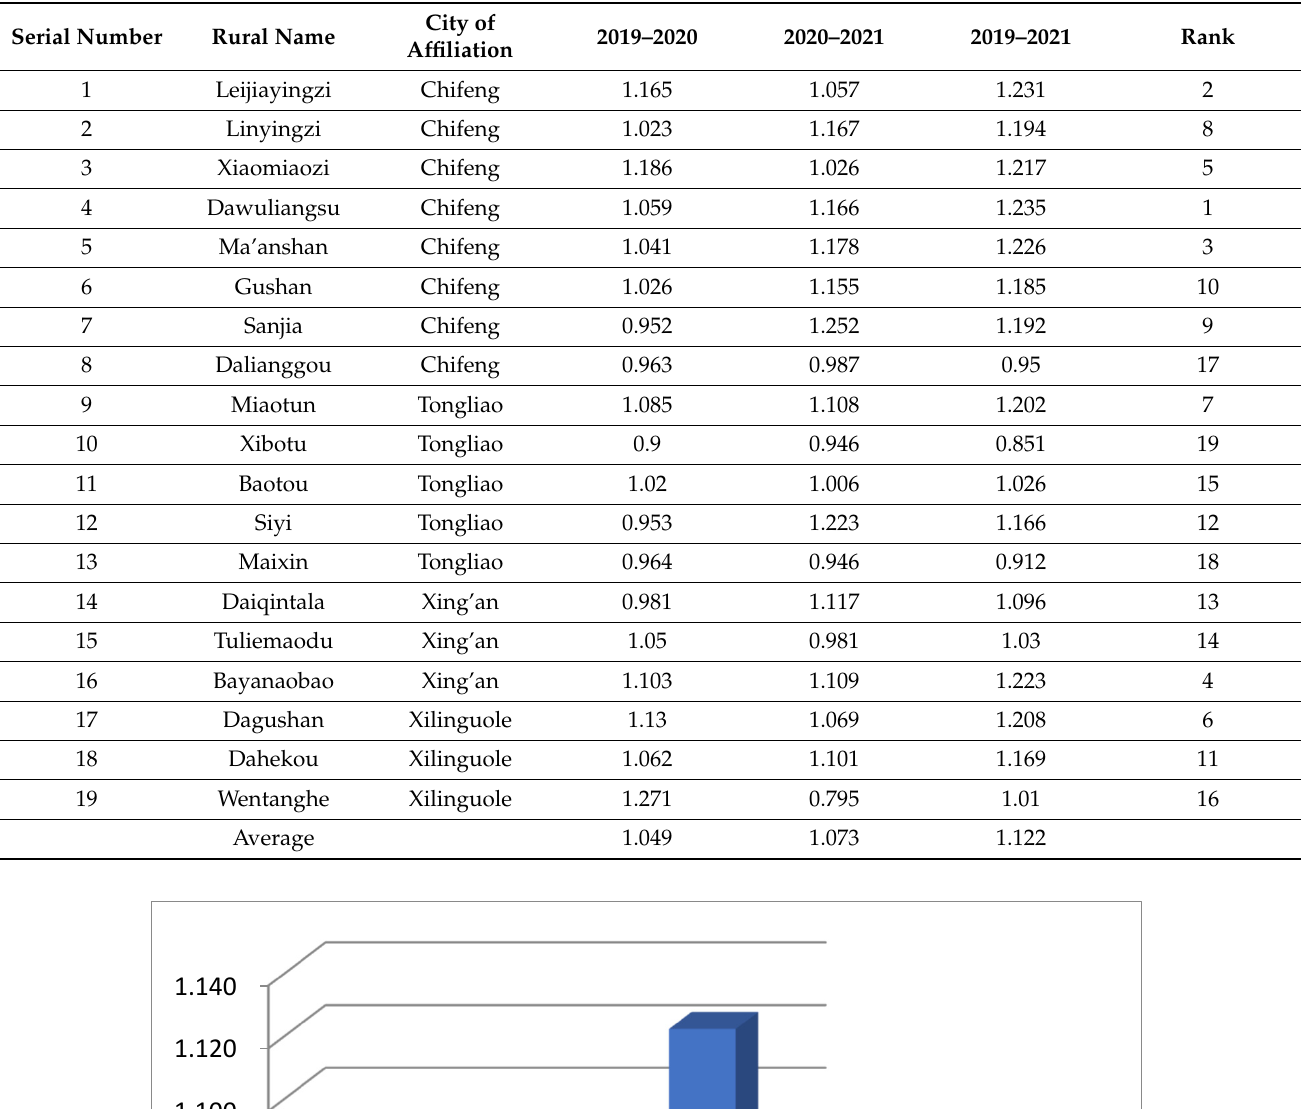
Table 4. GML index for assessing the value of rural preservation and inheritance in the Western Liao River Basin, Inner Mongolia, China.